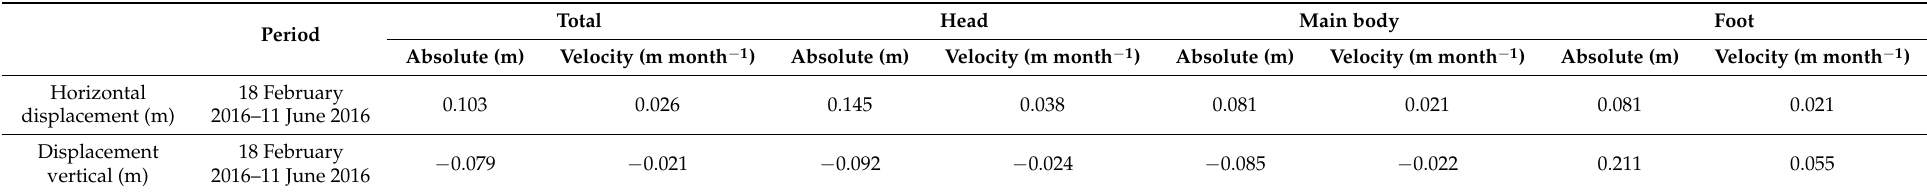
Table 8. Horizontal and vertical displacements and velocities calculated at monitoring points extracted in the landslide area of the Victoria study area. Displacements are expressed as m and velocities as m month − 1 .